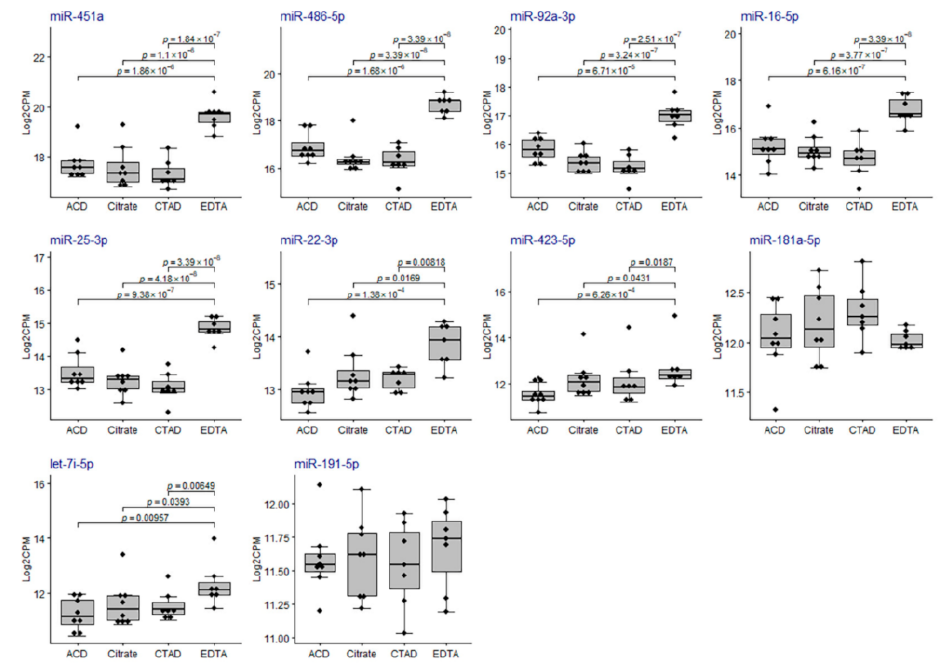
Figure 9. The distribution of miRNA expression for the top 10 RBC-derived miRNAs in the study sample groups. On the y -axis, TMM-normalized log 2 CPM values are shown. The boxplots represent median and interquartile ranges (IQRs) in the box and values for individual samples in the dots. p -values of statistical significance for the pairwise quasi-likelihood F-test comparisons performed in EdgeR are provided on the plots for each pair of the study groups with p < 0.05.